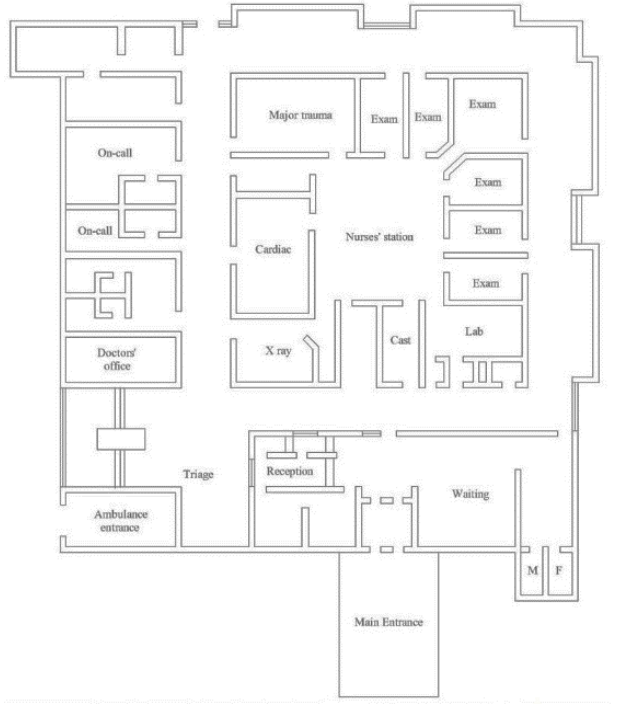
Fig. 2. Core Type Plan for Emergency Department